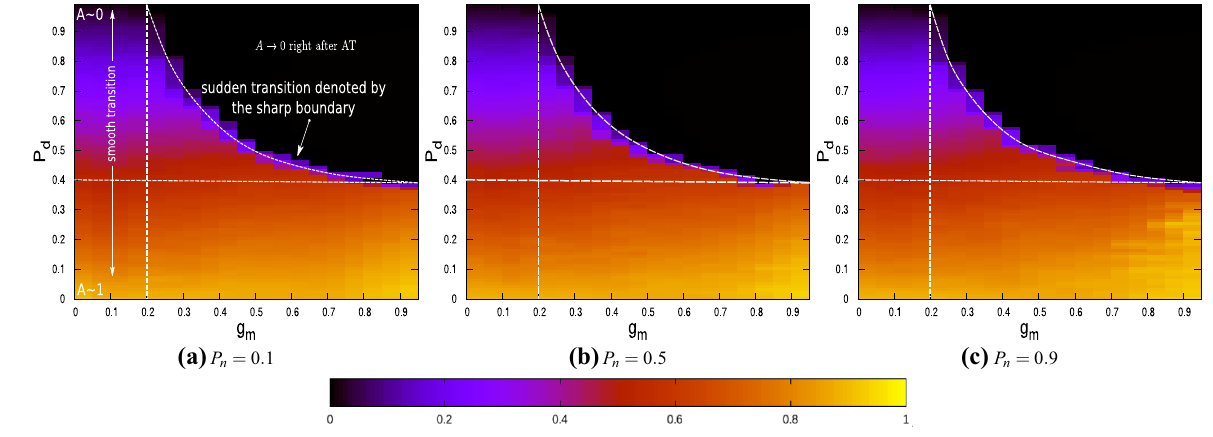
Figure 4. The order parameter A plotted as a function of both P d and g m for ( a ) P n = 0.1 , ( b ) P n = 0.5 and ( c ) P n = 0.9 . The dark/black coloured region shows where A → 0 whereas yellow shows where A → 1 . The colour- map which is common for all three figures is shown below the plots.